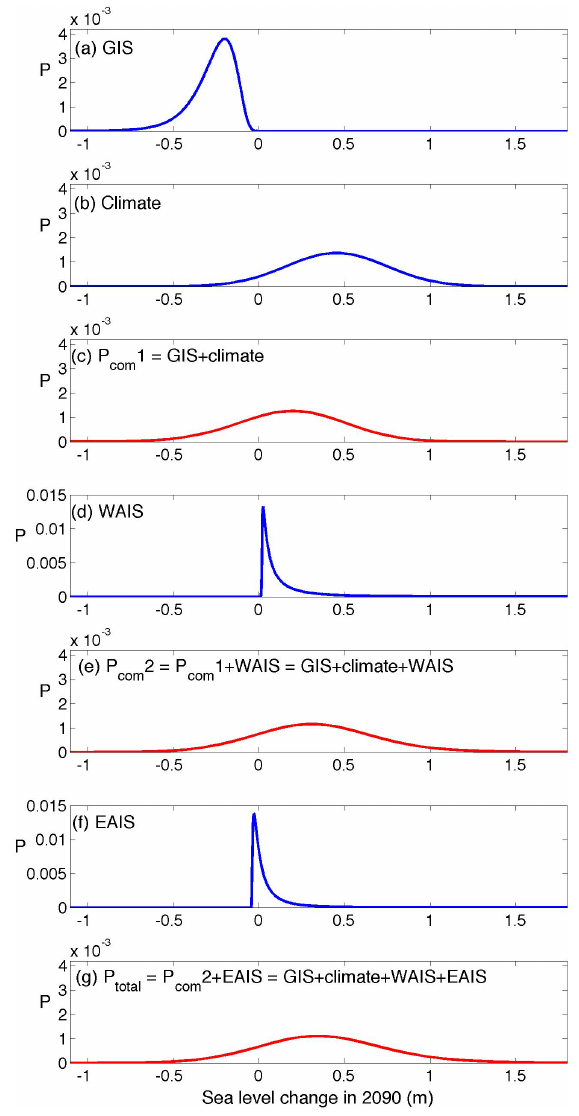
Figure 3. Example of the merging of several probability density functions (PDFs), here depicted for Denmark Strait (Fig. 4a). The input PDFs of dynamical ice sheet mass loss of the Greenland ice sheet (GIS) and climate forcing are merged following Eq. (1) to cal- culate P com 1. This combined PDF is subsequently combined with a PDF of the ice dynamical contribution of the West Antarctic ice sheet (WAIS) to sea level change to P com 2; finally the ice dynam- ical contribution of the East Antarctic ice sheet (EAIS) is added to construct P total . The input PDFs (blue lines panels a , b , d and f ) vary regional, as depicted in Fig. A1 for three